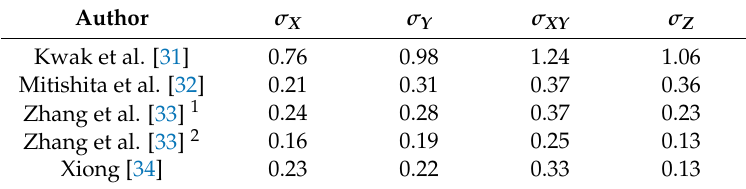
Table 5. Error statistics provided by authors with respect to Table 4 (Unit: